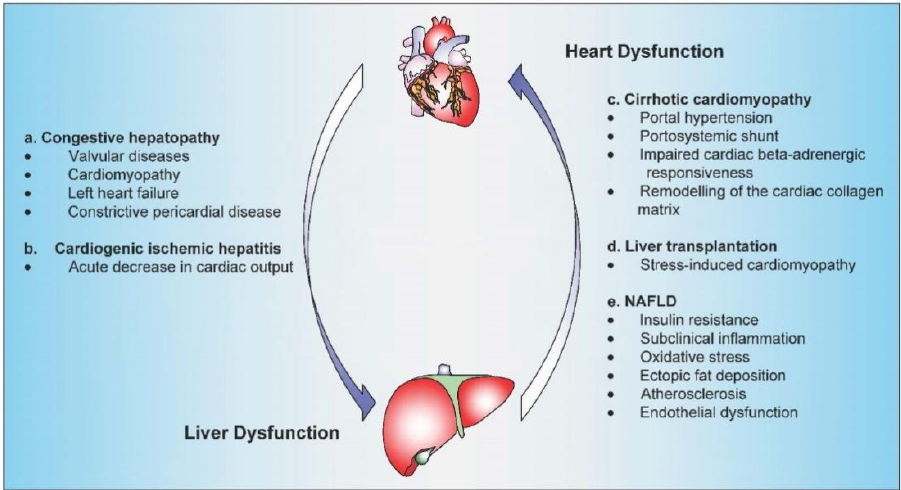
Figure 1. The suggested mechanisms underlying the cardiohepatic interactions in the setting of main heart and liver dysfunctions. (a) Congestive hepatopathy is most commonly observed in valvular heart diseases, cardiomyopathy, left heart failure, and constrictive pericardial disease. (b) An acute decrease in cardiac output may result in cardiogenic ischemic hepatitis. (c) In liver cirrhosis, the combination of portal hypertension, impaired cardiac beta-adrenergic responsiveness, and cardiac extracellular matrix remodeling isinvolved in the development of cirrhotic cardiomyopathy. (d) Stress cardiomyopathy is an acute heart failure syndrome that may appear in the perioperative period after liver transplantation. (e) Insulin resistance, subclinical inflammation, oxidative stress, ectopic fat deposition, atherosclerosis, and endothelial dysfunction are considered the main mechanisms linking NAFLD with cardiac complications.